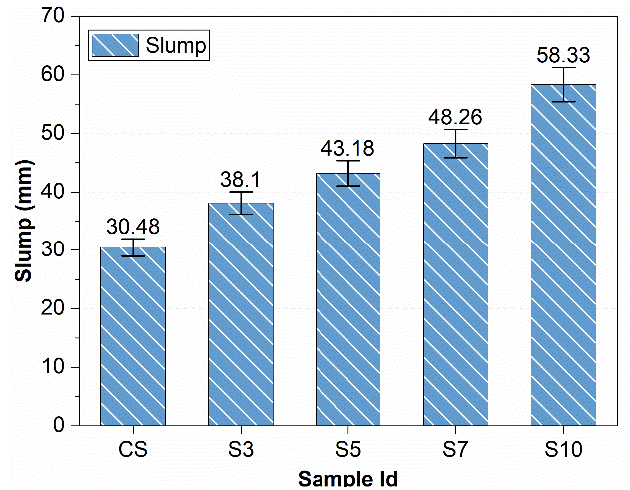
Figure 2. Concrete Slump Values (ASTM C143/C143M).